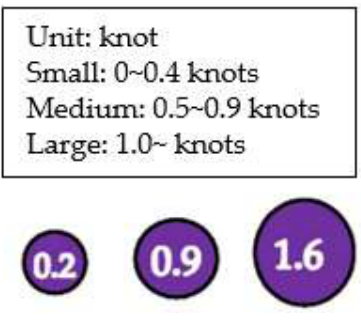
Figure 7. The levels of current speed.